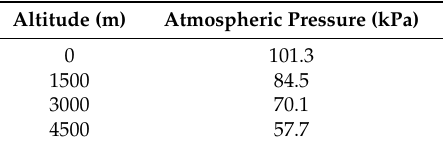
Table 3. Atmospheric pressure as a function of